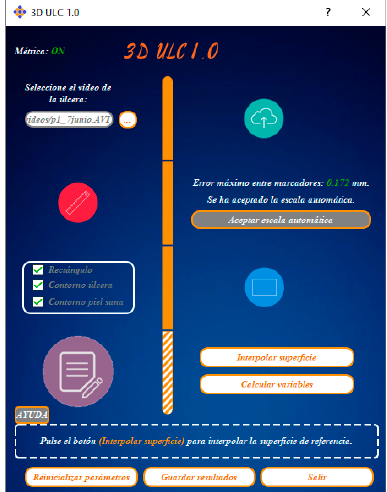
Figure 2. Application 2 user interface